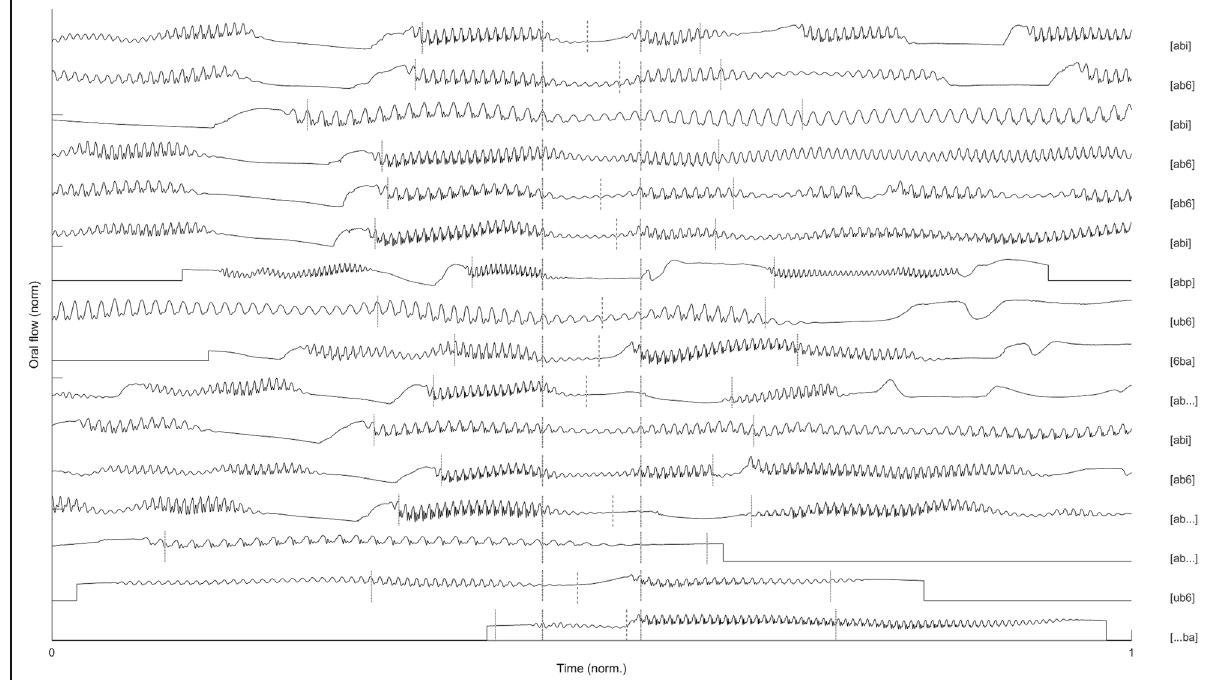
Fig. 5 Oral airflow waveforms of words with stop [b] (16 files), produced by male speaker SP1. The vertical dotted lines indicate the start of phone1 and the end of phone3. The vertical dash-dotted lines represent the phone1 – phone2 and phone2 – phone3 boundaries where phone2 is the stop. The vertical dashed lines indicate the burst when this is discernible in either the oral airflow waveform or its spectrogram. The x- and y- axes were